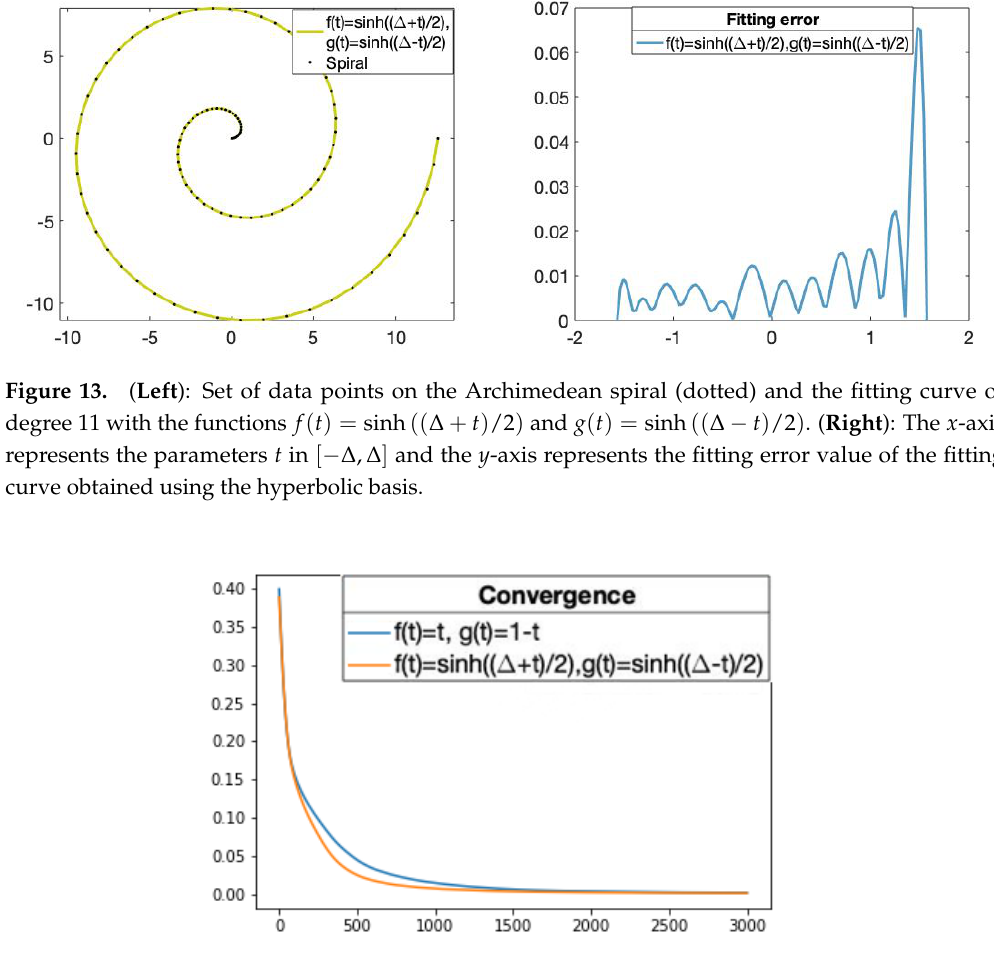
Figure 14. The history of the loss values, i.e., the mean absolute error values, through 3000 iterations of the training algorithm while the fitting curves converge is pictured. The blue line corresponds to the fitting curve of degree 11 obtained using f ( t ) = t and g ( t ) = 1 − t , t ∈ [ 0,1 ] , and the orange line corresponds to the fitting curve of degree 11 obtained using f ( t ) = sinh (( ∆ + t ) /2 ) and g ( t ) = sinh (( ∆ − t ) /2 ) . The x -axis represents the iteration of the training algorithm and the y -axis represents the mean absolute error value. The values are the mean of 50